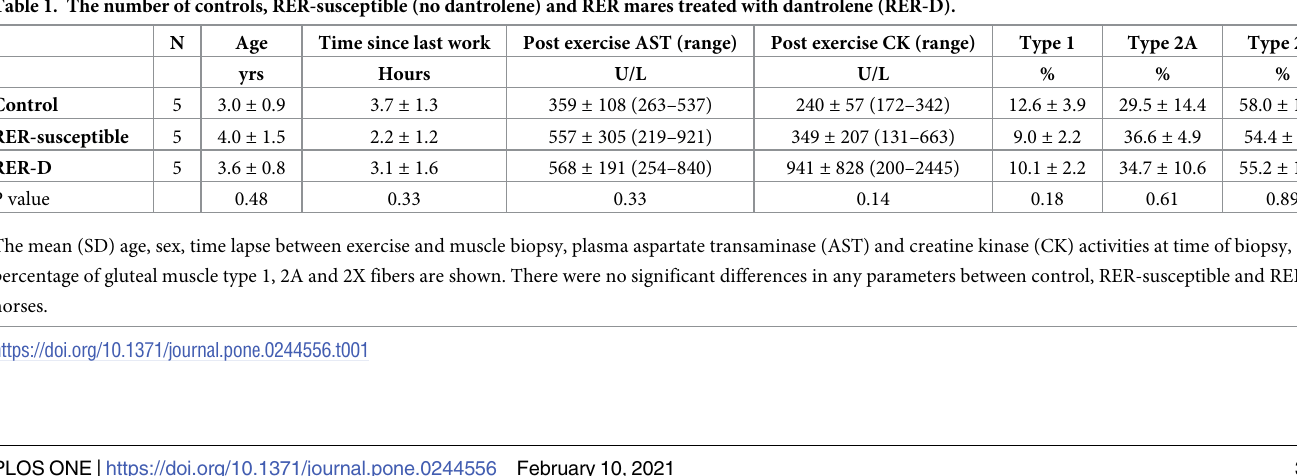
Table 1. The number of controls, RER-susceptible (no dantrolene) and RER mares treated with dantrolene (RER-D).